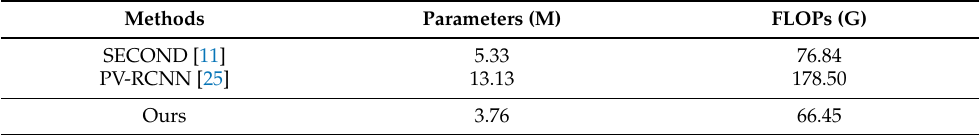
Table 13. Network parameters (M) and FLOPs (G) of our model and other